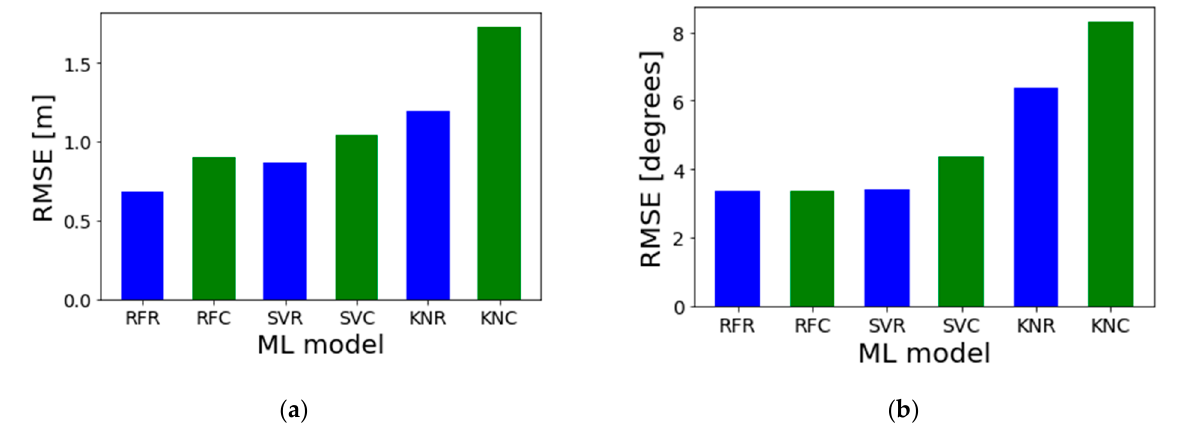
Figure 9. RMSE of ML models for ( a ) the vertical excavation problem and ( b ) the inclined slope stability problem.